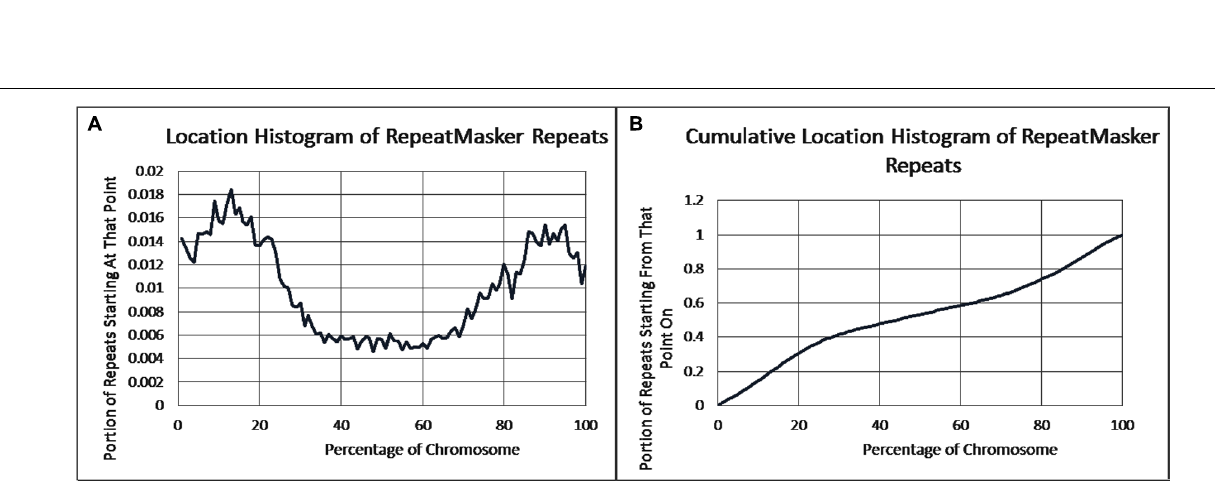
FIGURE 1 | Cosmid andYAC locations. (A) The fraction of cosmids andYACs starting at each percent point of their chromosomes on average. (B) The cumulative probability distributions of cosmids andYACs on average. For each percentage point the fraction of clones starting at that point or further is given.